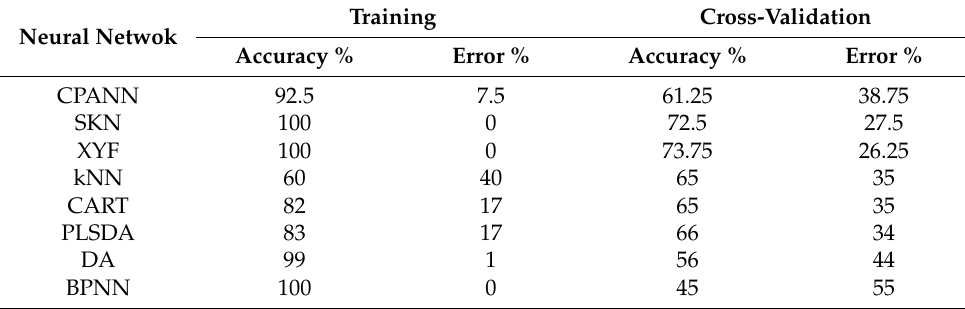
Table 2. Comparison of SOM Neural Networks with others.